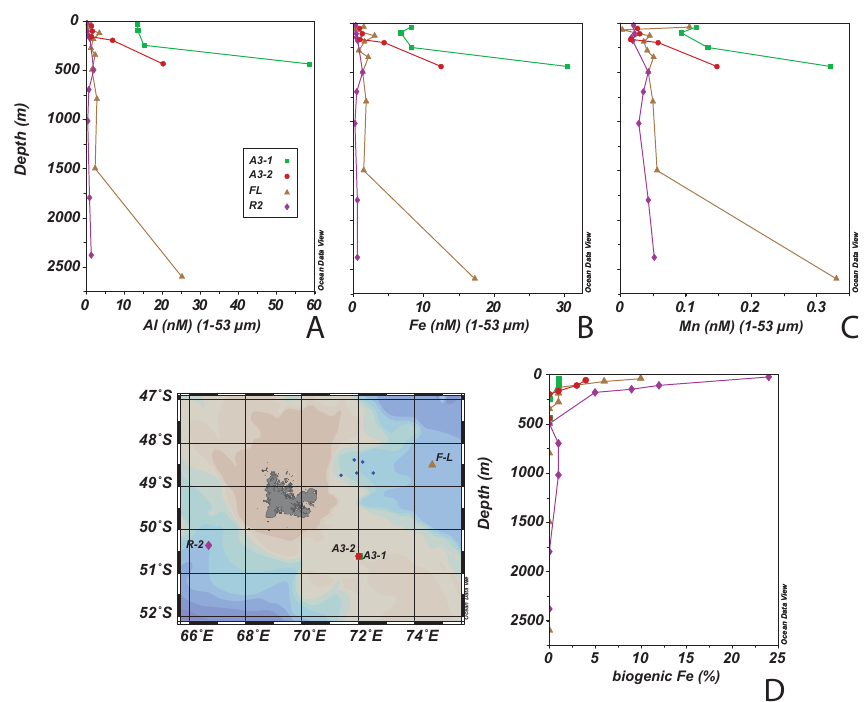
Figure 3. Profiles of particulate Fe (a) , Al (b) and Mn (c) (1–53µm) at the reference HNLC station (R-2), the northern PF station (F-L) and pre- and post-bloom over the plateau station (A3-1, A3-2), highlighting the contrasting particulate trace metal supply to these locations. Biogenic Fe (d) (as a percentage of the total Fe) in surface waters shows a clear progression that can be explained by the location of each station within the study area whereby, biogenic Fe at R-2>>F-L>A3-2>A3-1.